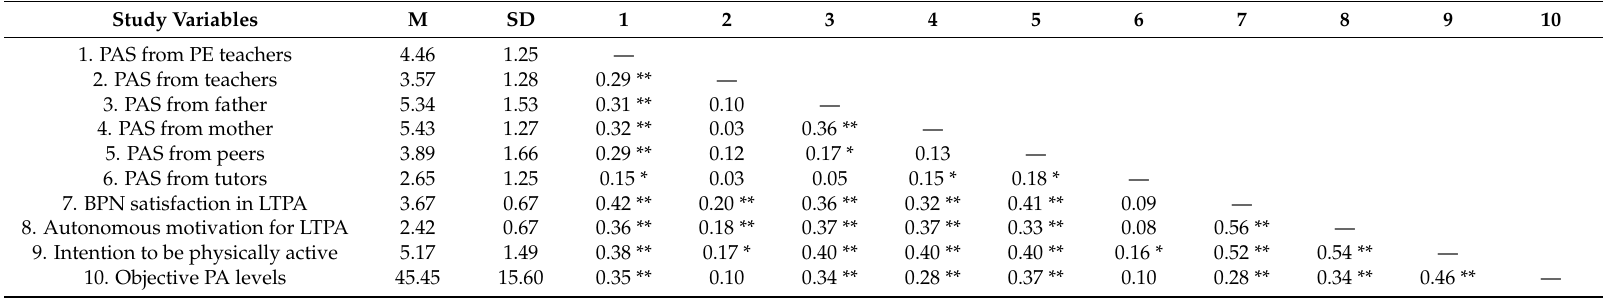
Table 1. Descriptive statistics and Pearson’s bivariate correlations between study